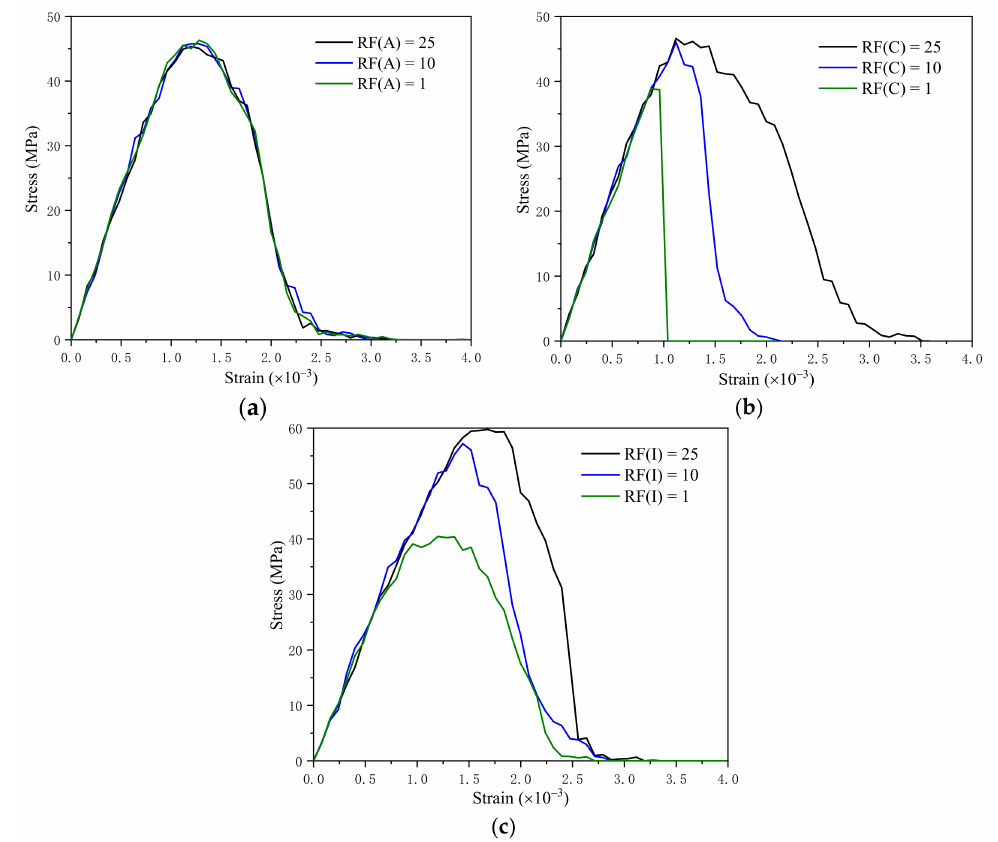
Figure 7. Different fracture energy ratios (RF) of three internal interfaces (AIE, CIE and ITZ): ( a ) Dif- ferent fracture energy ratios of AIEs; ( b ) Different fracture energy ratios of CIEs; ( c ) Different fracture energy ratios of